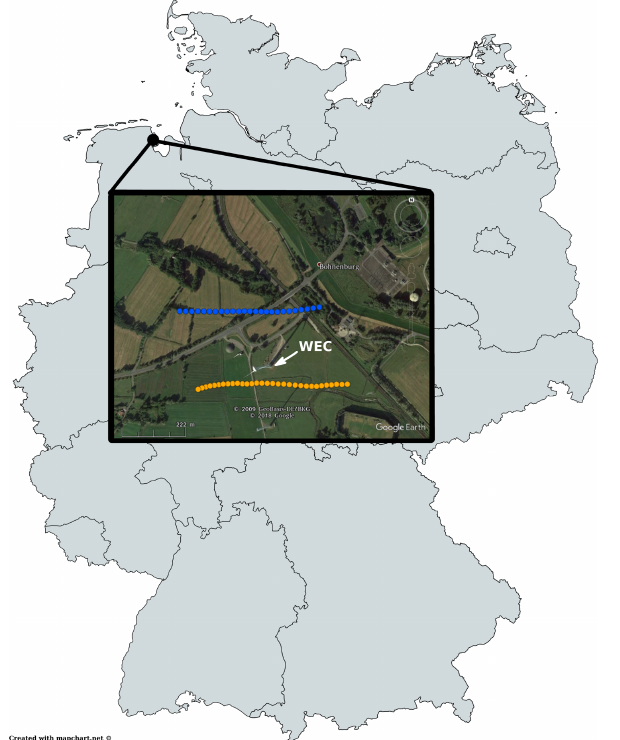
Figure 3. Location of the E-112 WEC in the north-west of Ger- many north of Wilhelmshaven near the North Sea coast. MASC flight tracks in front (blue) and in the wake (orange) of the E- 112 with northern main wind direction (5 ◦ north that day). On the © Google Earth image, the WEC is oriented toward the south- easterly wind direction. The map was created with https://mapchart. net (last access: 1 July